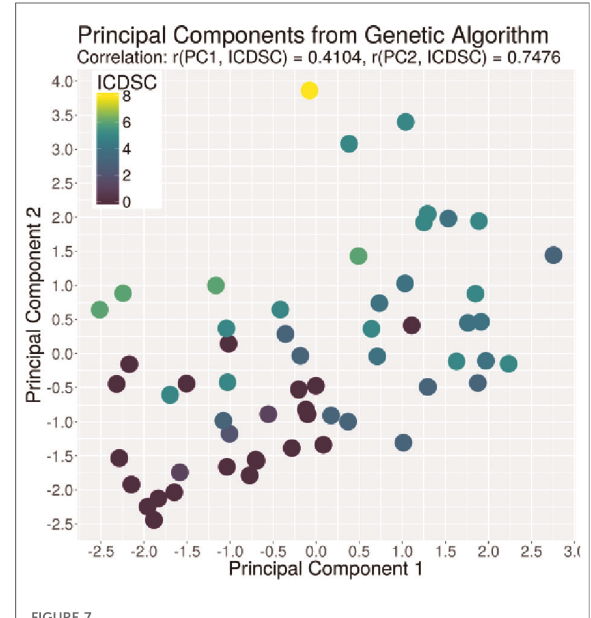
FIGURE 7 Plot of the principal component derived by the GA based on the ICDSC score on the x -axis and the principal component derived by the GA based on the ICDSC on the y -axis. Every dot represents one patient on day 1, color-coded with the ICDSC index on that day.